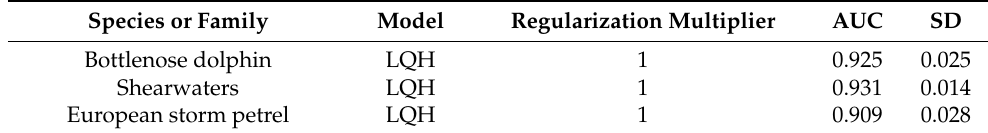
Table 4. MaxEnt AUC and standard deviation (SD) values relative to the predictive model (LQH) analyzed for bottlenose dolphins, shearwaters, and European storm petrel.